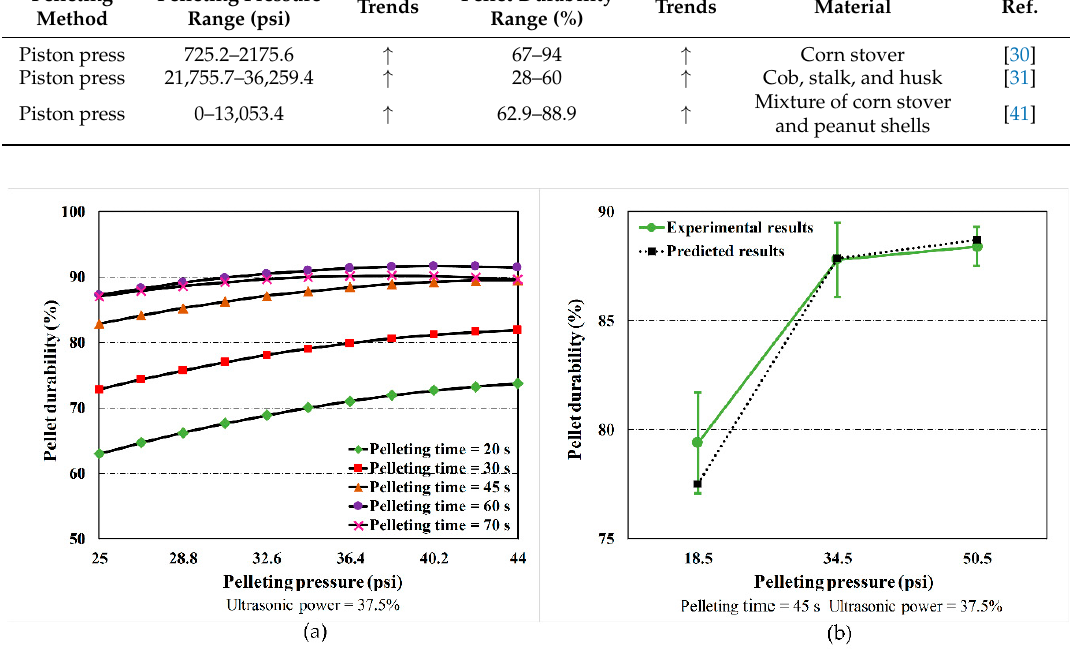
Figure 7. The effects of pelleting pressure on pellet durability. ( a ) The predicted pellet durability in relation to pelleting pressure at different levels of pelleting time (ranging from 20 s to 70 s) when the ultrasonic power was set to 37.5% and the pelleting pressure increased from 25 psi to 44 psi. ( b ) For pellet durability, the comparison between model results and experimental results at various levels of pelleting pressure (mean value ± SD).